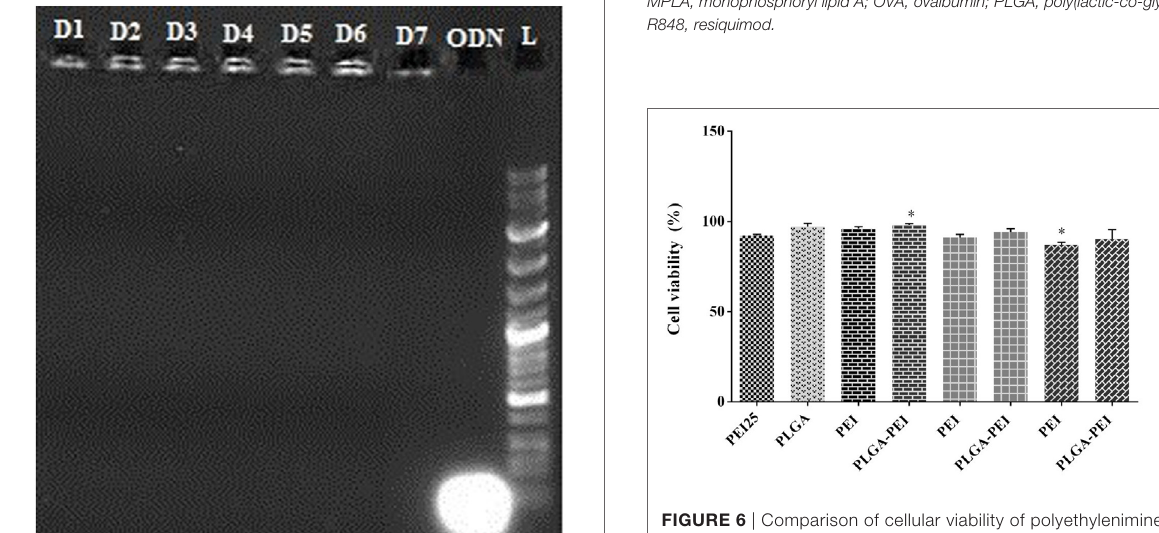
FigUre 6 | Comparison of cellular viability of polyethylenimine (PEI) 25 kDa (C/P 0.8) as control with PEI and cationic poly(lactic-co-glycolic)